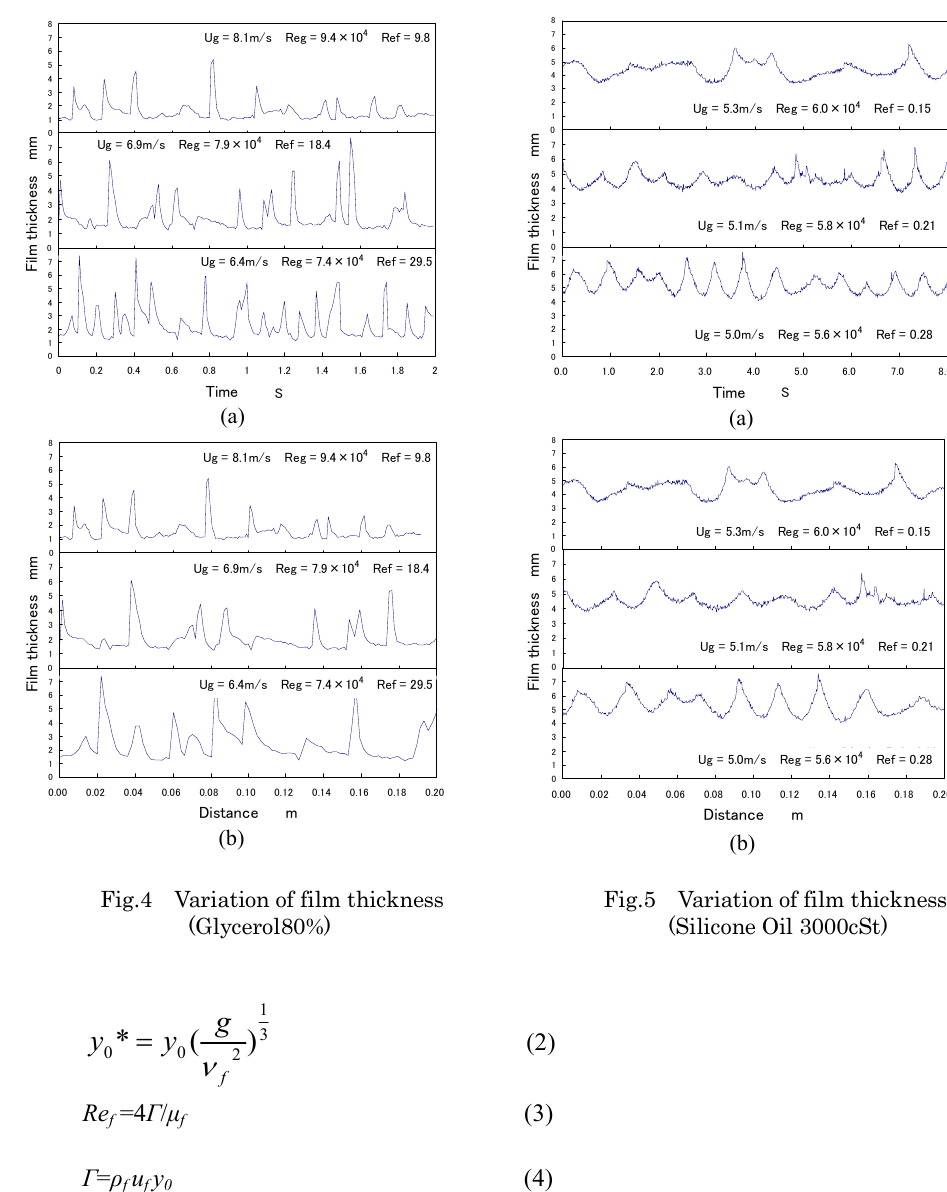
Fig.4 Variation of film thickness (Glycerol80%)